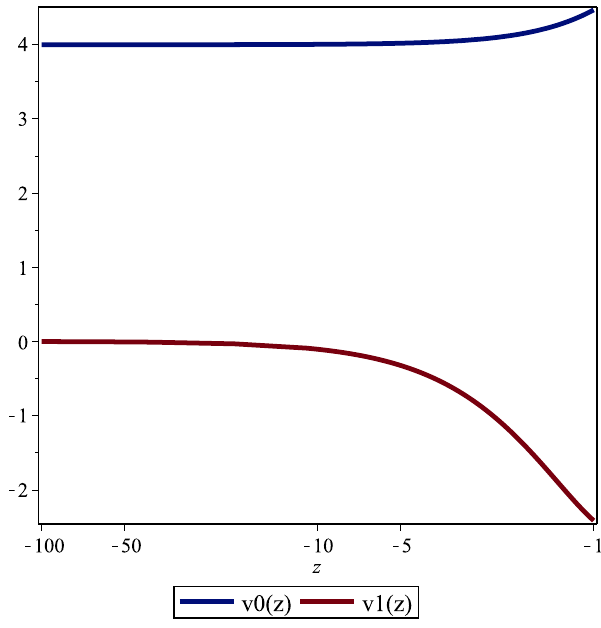
Figure 3. Graphs of functions v 0 ( z ) and v 1 ( z )